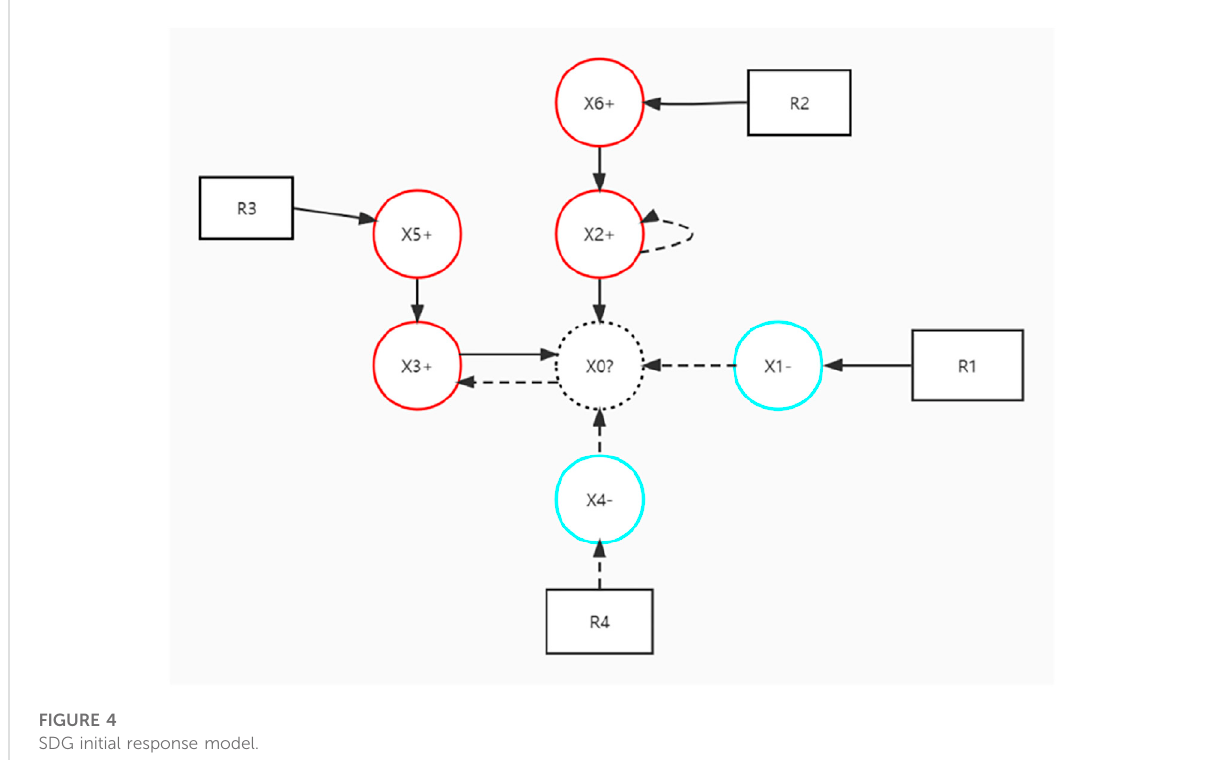
FIGURE 4 SDG initial response model.